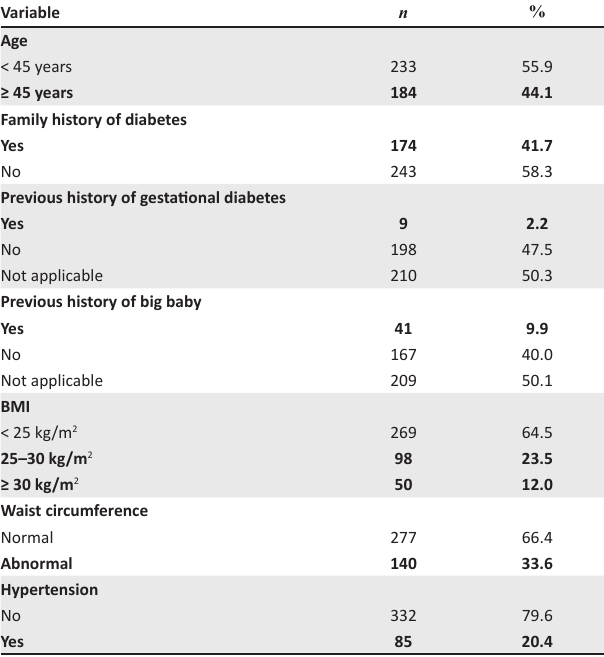
TABLE 3: Magnitude of missed opportunity based on the guideline- recommended risk factors for prediabetes screening.